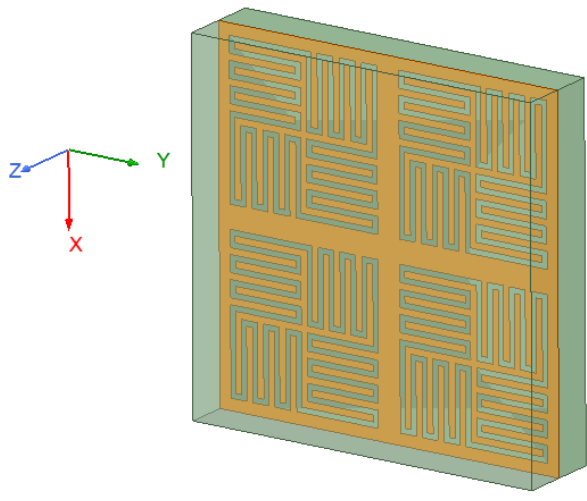
Figure 3. Perspective of overall structure of the proposed unit.